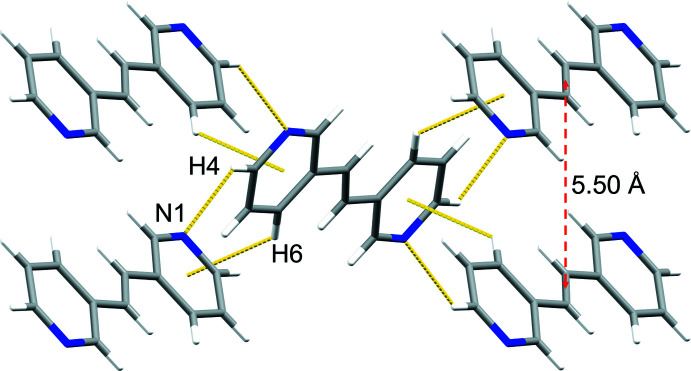
C—H⋯N and edge-to-face C—H⋯π inter­molecular inter­actions (both yellow dotted lines) highlighting nearest-neighbor alkene separations (red dashed arrow) (view along a).